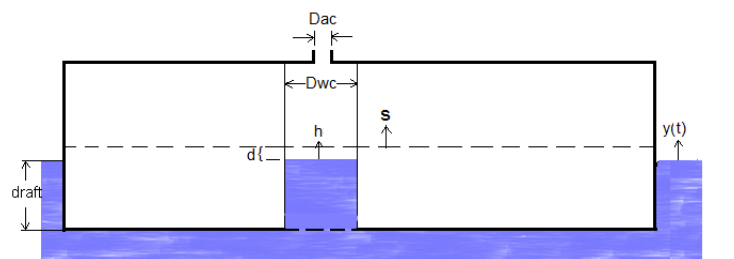
Figure 3. Cross-sectional view of a cylindrical buoy. The OWC consists of an air chamber with diameter Dwc and an air turbine placed in the outlet with diameter Dac . y ( t ) , s , and h are the water surface, the buoy position, and the water column position, respectively (not to scale).